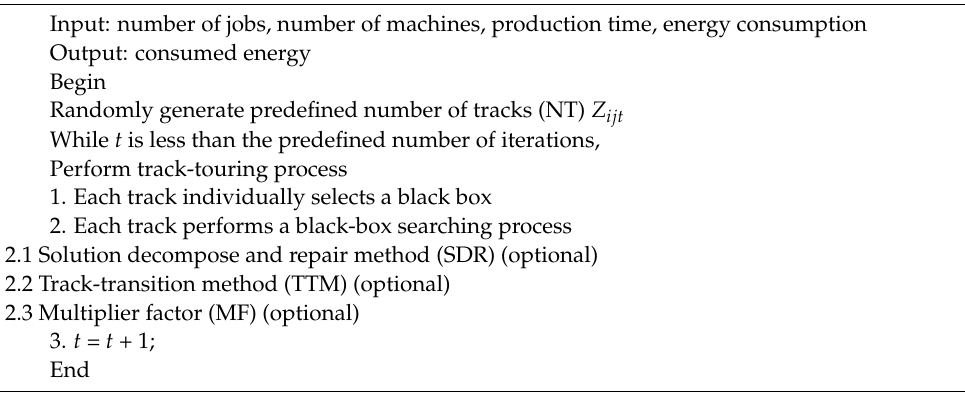
Algorithm 1. Variable neighborhood strategy adaptive search (VaNSAS).